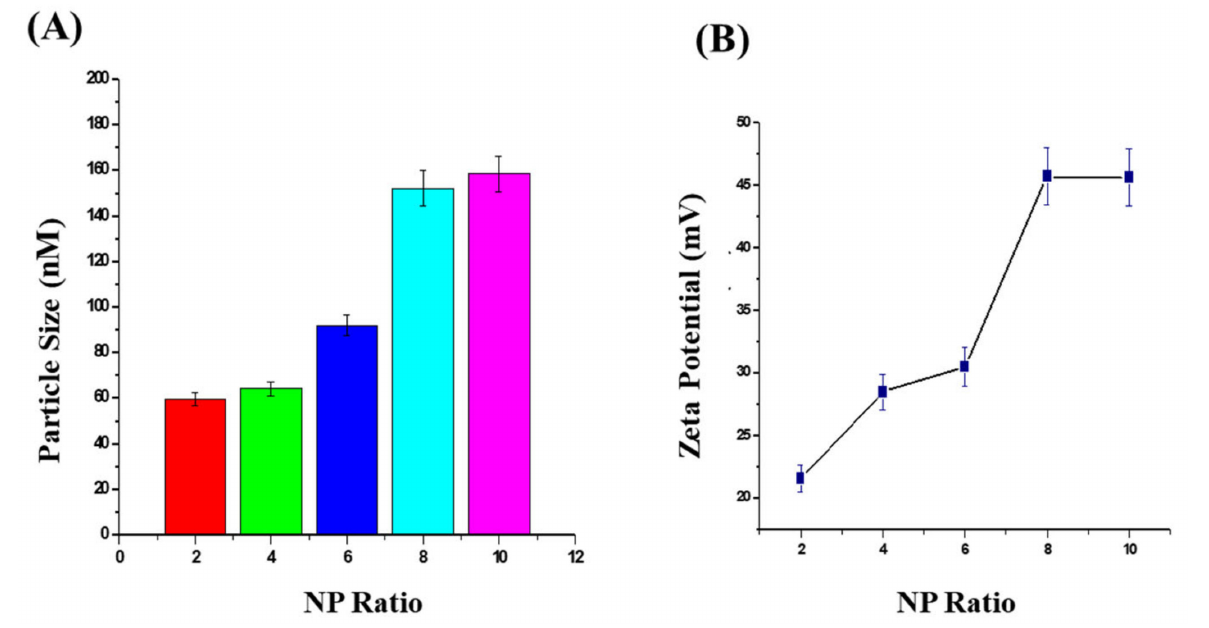
Figure 2. Representation of the trend of solid lipid nanoparticles particle size (nm) ( A ) and Zeta po- tential with N/P ratio at fixed siRNA concentration ( B ). All the values are expressed as mean ± SEM ( n = 3).